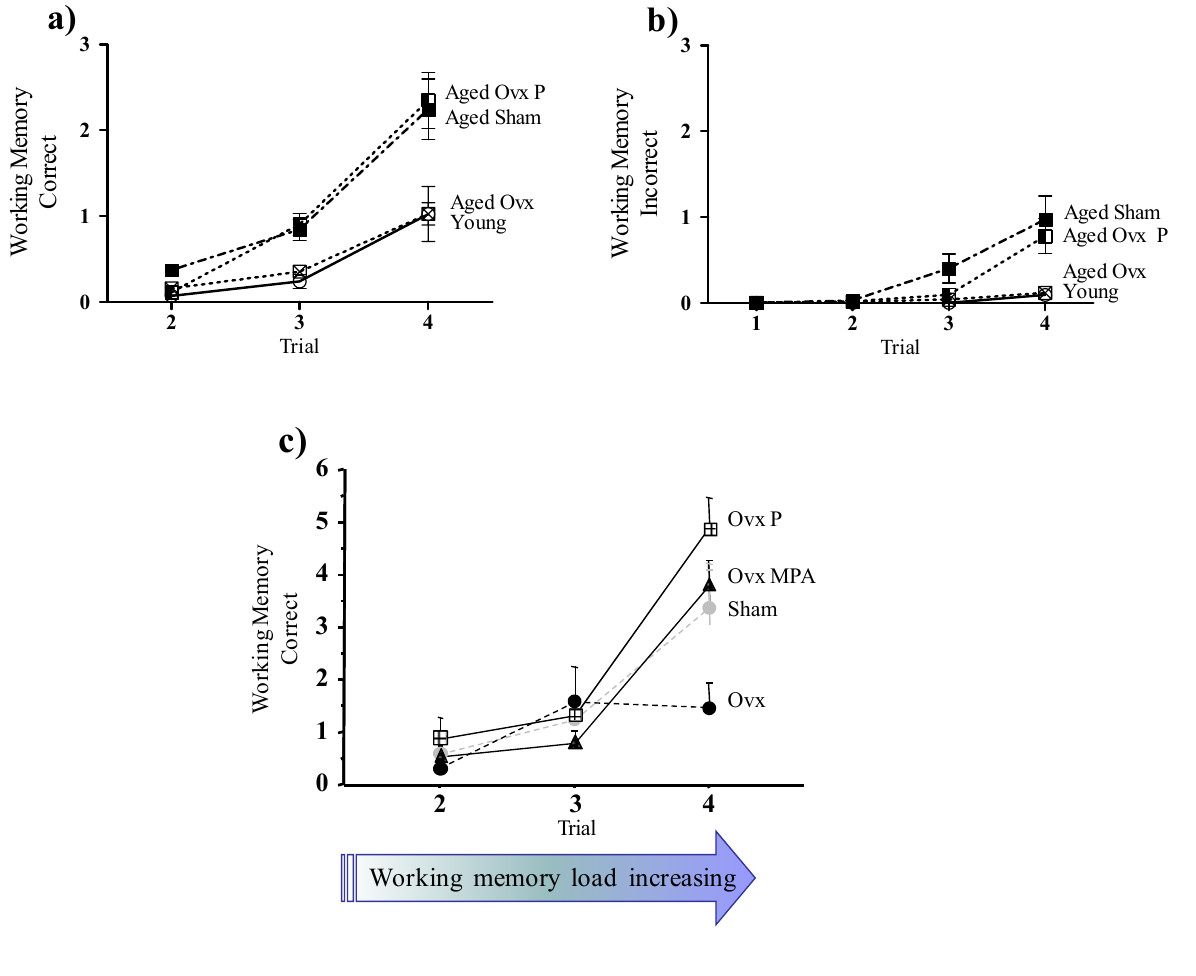
Figure 6. Progesterone reverses the cognitive enhancing effects of Ovx in aged animals, an effect paralleled by the synthetic progestin medroxy progesterone acetate (MPA) [58,91]. a) and b) represent the mean ± SE number of working memory correct and incorrect errors, respectively, committed on the water radial-arm maze for Young, Aged Sham, Aged Ovx, and Aged Ovx P (progesterone) treated animals [for error definitions see 58]. Young Sham and Aged Ovx rats were better able to sustain successful performance as trials and working memory load increased, compared to Aged Sham and Aged Ovx rats treated with progesterone (Aged Ovx P). Thus, on the two orthogonal spatial working memory measures, aged animals showed impaired performance as memory load increased relative to young animals, and Ovx enhanced performance in aged rats. Progesterone abolished the Ovx-induced enhancement. c) represents the working memory load effect whereby Sham, OvxP, and OvxMPA animals exhibited more mean±SE errors than Ovx animals on the last trial, indicating that animals treated with progesterone or MPA were impaired as the demand on working memory increased. This replicated prior findings that Ovx enhanced, and progesterone impaired, performance as memory load increased, and showed that the synthetic progestin, MPA, impaired spatial working memory as memory load increased in aged surgically menopausal